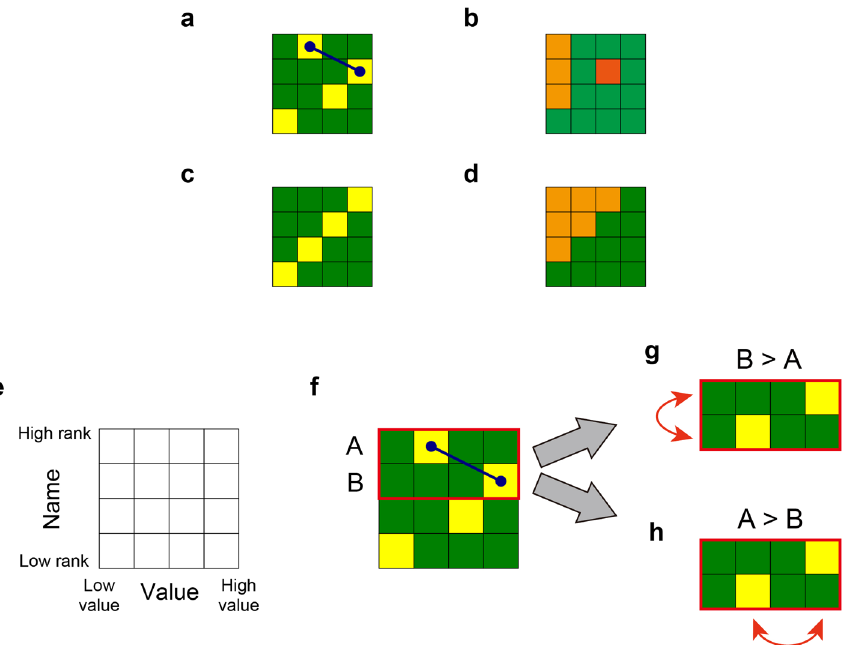
Figure 4. Order recognition principle based on Schubert polynomials. ( a ) Inversion relation (marked by a blue arrow) inherent in the Schubert matrix. ( b ) Young tableau (orange colour) and a singularity (red colour). ( c ) Illustration of an anti-diagonal matrix and ( d ) its diagram consists of a Young tableau with the maximum inversion number. ( e ) In the proposed ordering strategy, a matrix is characterized by the name and value axes, which correspond to the vertical and horizontal directions, respectively. In the name axis, the upper row indicates a high rank and in the value axis, the right column indicates a high value. ( f ) Our decision of machine selection is suggested by the Schubert matrix. We paid attention to the inversion relation of the given matrix, which is the first and the second row in ( f ). Let us assume that the names of the first and second rows be machines A and B, respectively. The inversion relation suggests a contrary situation between the name and value axes. ( g ) If the reward dispensed by machine B is greater than that by machine A, the association of the name axis is inaccurate; hence, the allocation of the names is swapped. ( h ) If the reward by machine A is larger than that by machine B, the association of the value axis is inaccurate; therefore, the allocation of the values is